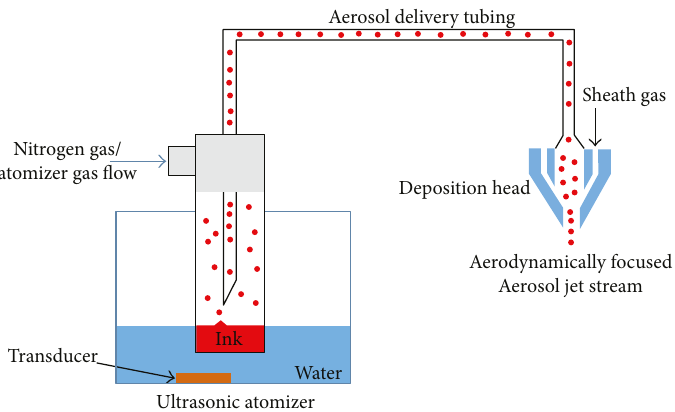
Figure 5: Aerosol jet printing operation process [41]. Table 1: Compatible materials for aerosol jet printing [43]. Conductive